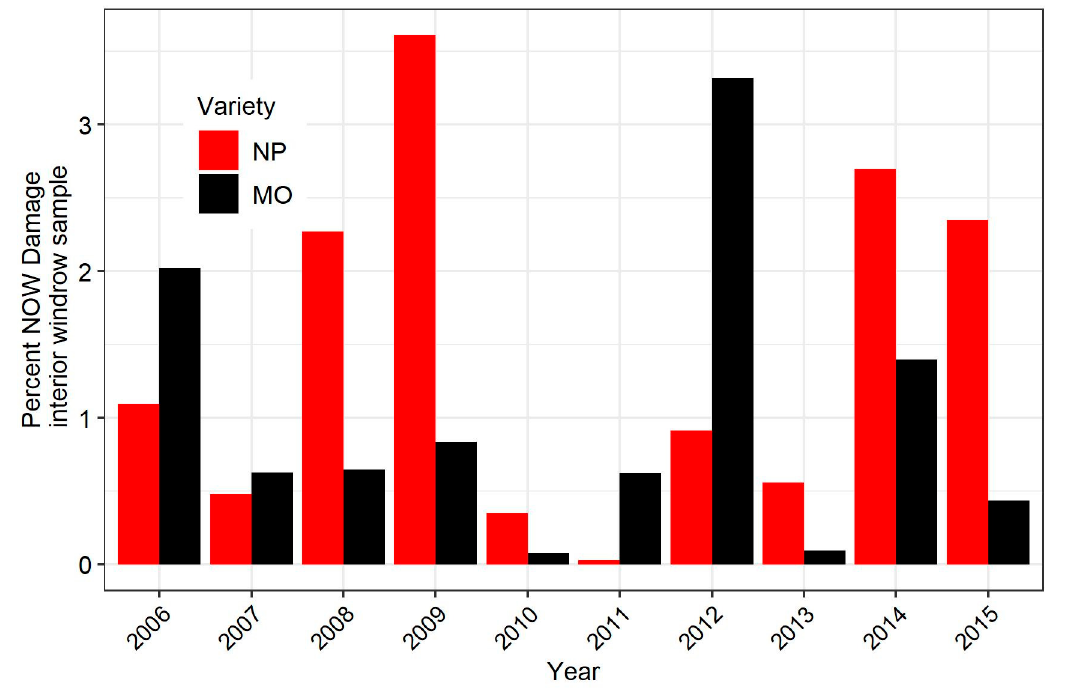
Figure 3. Percent navel orangeworm damage by year in Nonpareil and Monterey almonds in plots treated only with insecticide.